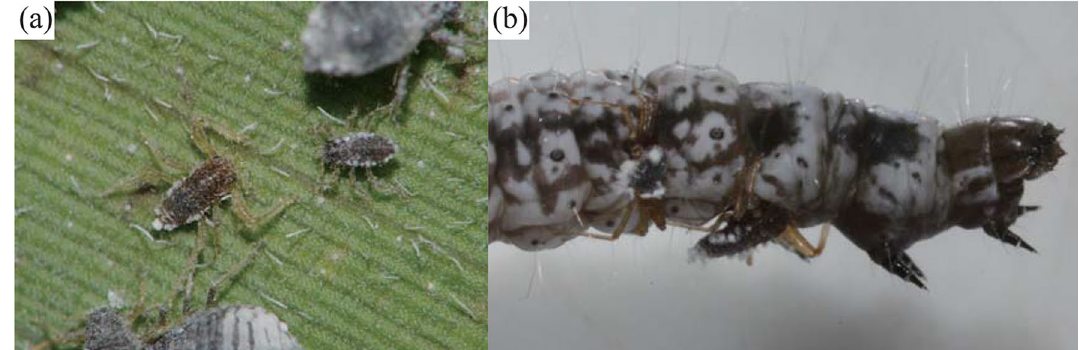
Figure 1. ( a ) A soldier (left) and a 1st-instar reproductive individual (right) in Ceratovacuna japonica (photo courtesy of Takashi Komatsu, Ibaraki Nature Museum). ( b ) Soldiers attacking a larva of Atkinsonia ignipicta . Soldiers attack predators with their horns and